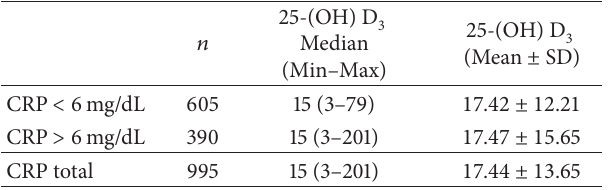
Table 5: Vitamin D levels in patients with inflammation and 3 without inflammation.